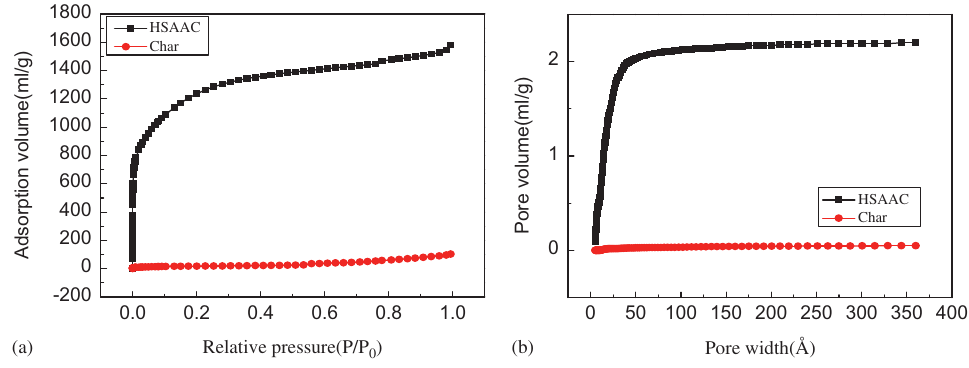
Figure 6: Nitrogen adsorption isotherm (a), cumulative pore volume distribution chart (b).